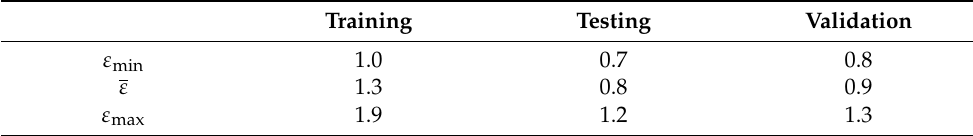
Table 4. Performance statistics for the non-dominated set.